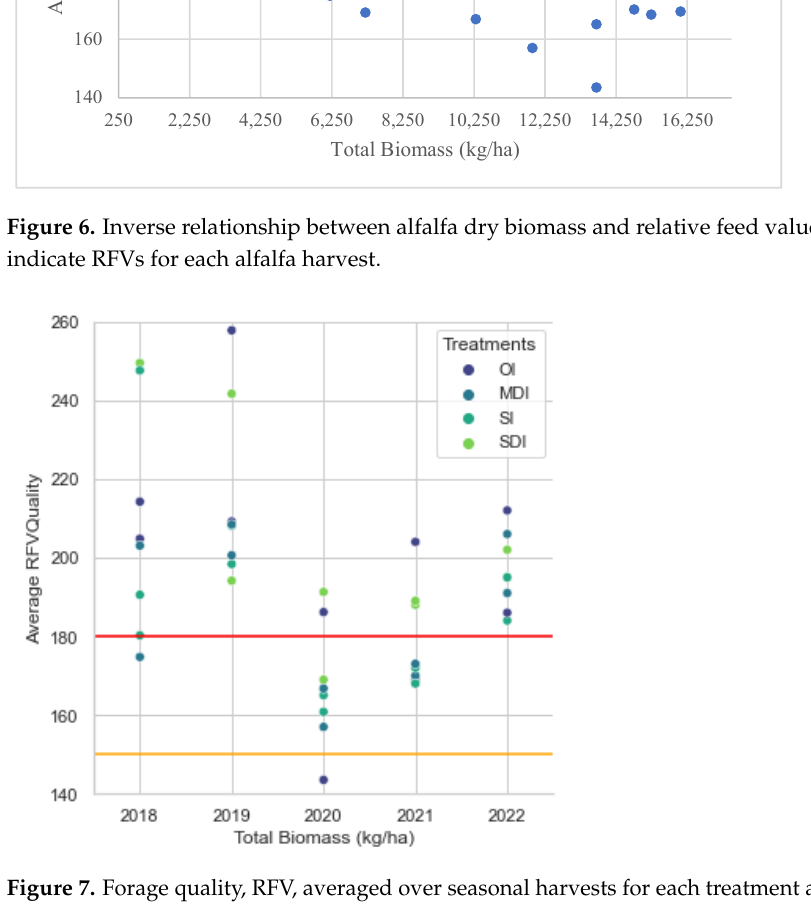
Figure 7. Forage quality, RFV, averaged over seasonal harvests for each treatment and year. The lines show the cutoffs between supreme and premium (red line) and premium and good (orange line) feed qualities.